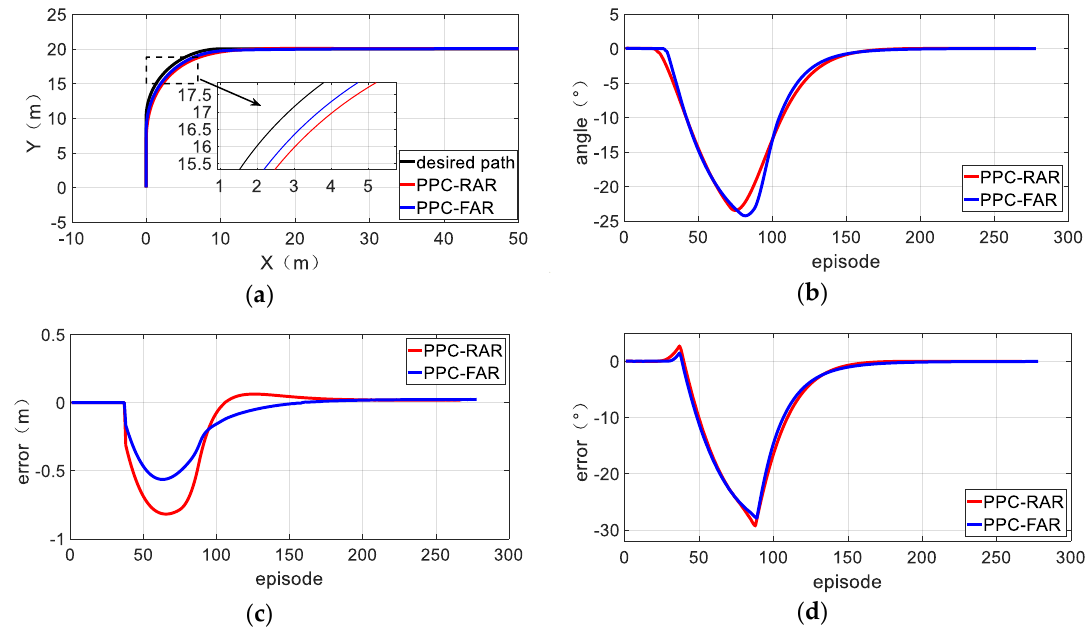
Figure 17. The performances of PPC-RAR and PPC-RAR. ( a ) Desired path and bus’s path under different conditions. ( b ) Steering angle. ( c ) Lateral error. ( d ) Heading error.